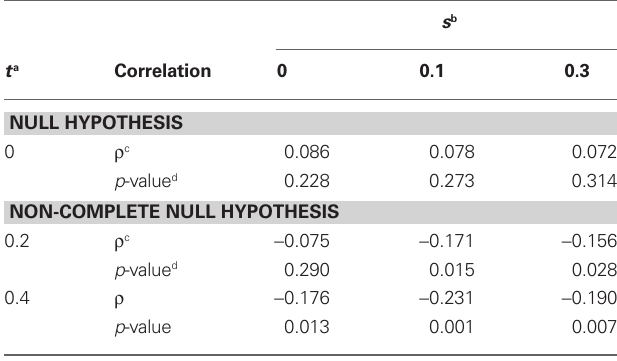
Table 1 | Correlation evaluations of two test statistics in stage 1 and stage 2 for our two-stage procedure.